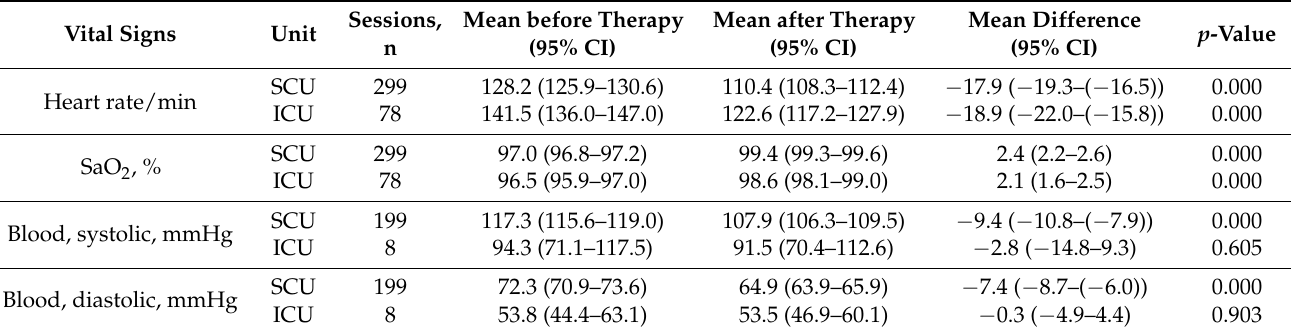
Table 5. Heart rate, oxygen saturation and blood pressure before and after music therapy sessions at the SCU and